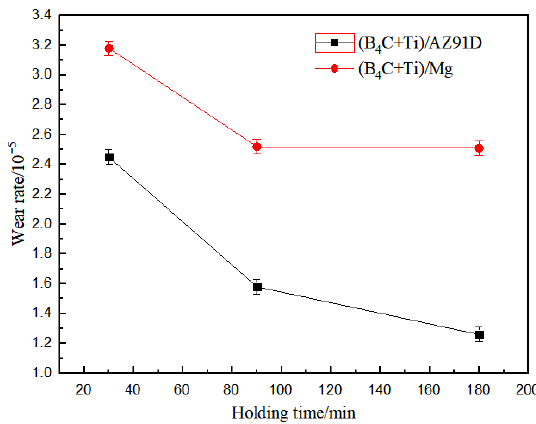
Figure 4. Relationships between the wear rates of (B 4 C+Ti)/Mg and (B 4 C+Ti)/AZ91D composites and holding time.